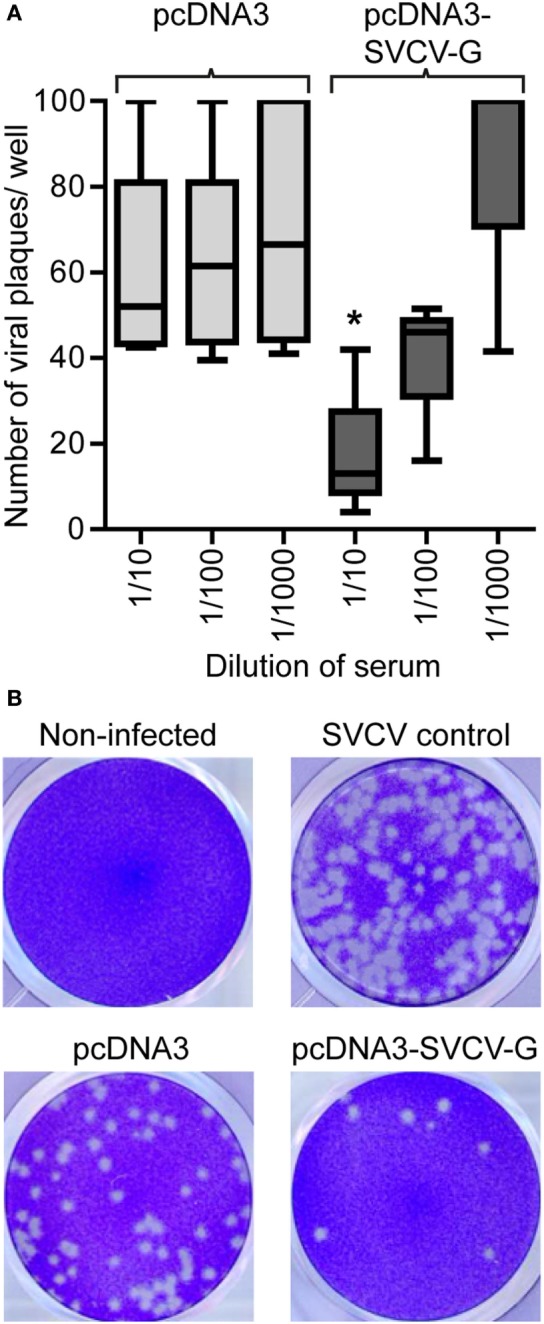
Neutralizing capacity of serum from i.m. DNA vaccinated carp. Serum (n = 5/group) was collected from vaccinated [pcDNA3-spring viremia of carp virus (SVCV)-G] and non-vaccinated (pcDNA3) carp 3 months after vaccination and used in a neutralization assay using the SVCV VR-1390 strain. Epithelioma papulosum cyprinid (EPC) cells were fixed and stained with crystal violet after 3 days of infection. (A) Quantification of the number of virus plaques per well. Box plots indicate the minimum, maximum, and average plaques count. The upper threshold on the number of counted plaques, indicating a fully infected well, was set at 100 plaques. Asterisk (*) (p < 0.05) indicates a significant difference between the pcDNA3 and the pcDNA3-SVCV-G group at the given dilution as assessed by an one-way ANOVA. (B) Representative pictures of wells containing non-infected EPCs monolayers (non-infected), EPC infected with SVCV only in the absence of carp serum (SVCV control), SVCV incubated with serum from pcDNA3 injected control fish (pcDNA3) or with serum from pcDNA3-SVCV-G vaccinated fish (pcDNA3-SVCV-G).